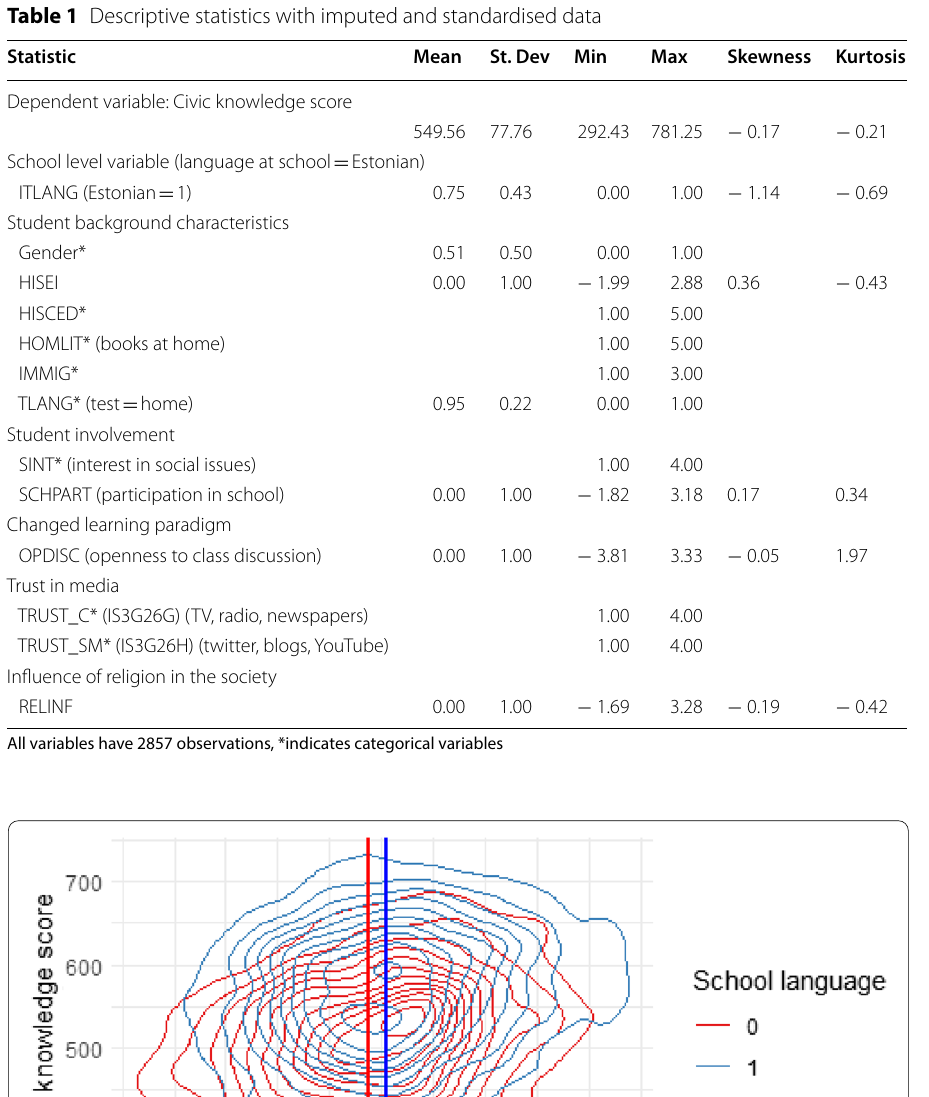
Table 1 Descriptive statistics with imputed and standardised data Statistic